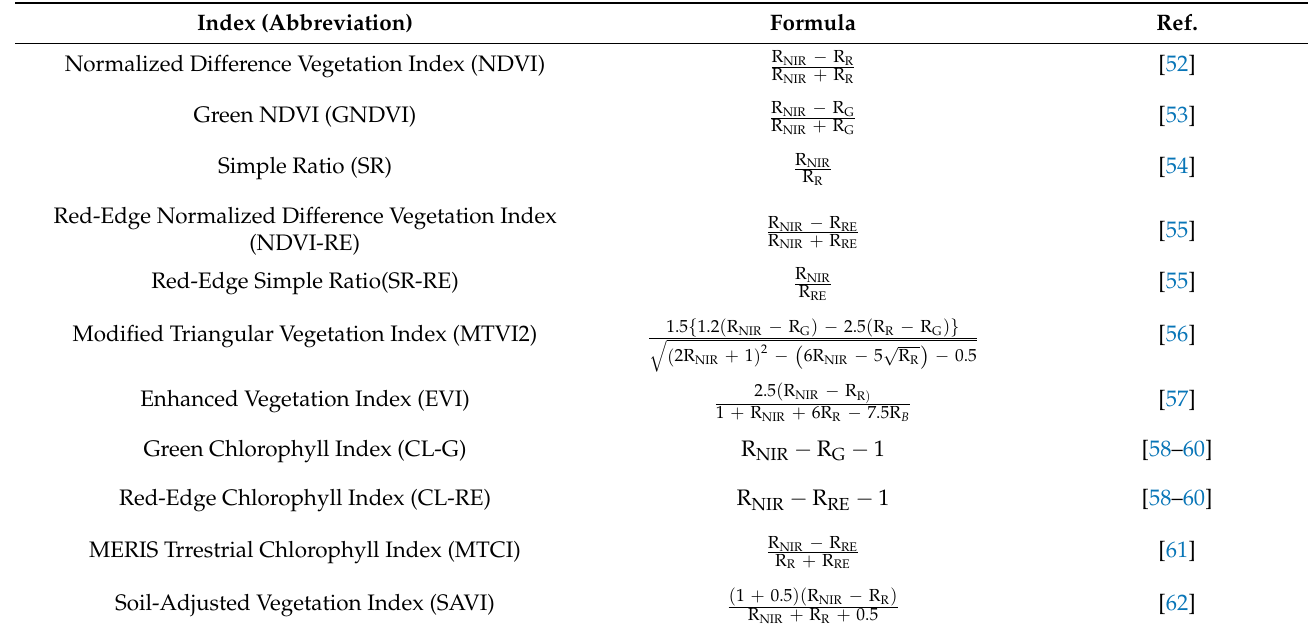
Table 2. Detail of the VIs extracted from RapidEye optic sensor used in this